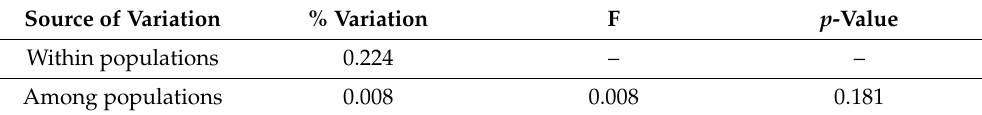
Table 2. Analysis of molecular variance among three focal ponds of A. opacum . F-values were calculated using the stepwise mutation model, as such F-values are equivalent to R ST . Source of Variation % Variation F p -Value Within populations 0.224 – – Among populations 0.008 0.008